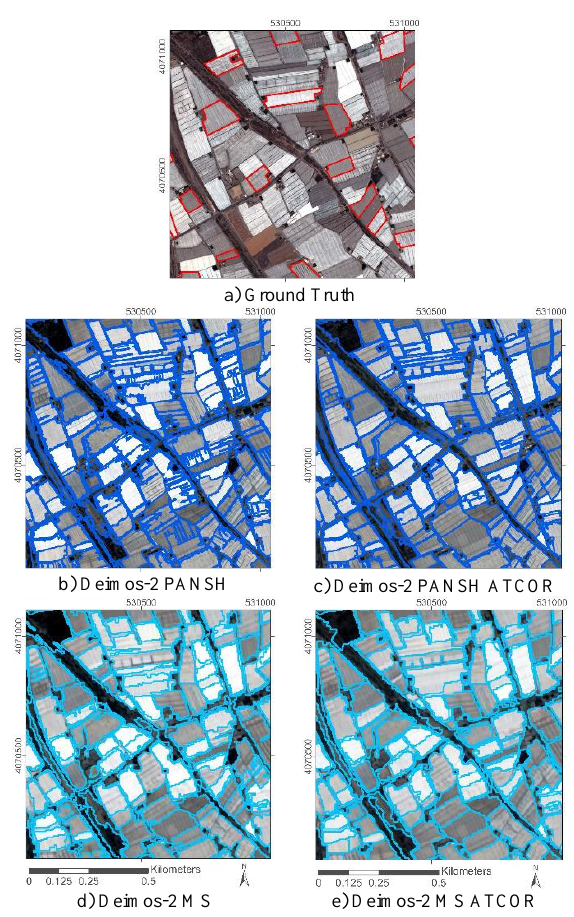
Figure 7 . Visual comparison of the best achieved segmentations using MRS and AssesSeg over the corresponding RGB orthoimages: a) Reference geometries (400 red polygons) over WV3 MS ATCOR orthoimage; b) Optimal segmentation (Navy blue objects) derived from Deimos-2 PANSH orthoimage; c) Optimal segmentation (Navy blue objects) derived from Deimos- 2 PANSH ATCOR orthoimage; d) Optimal segmentation (Clear blue objects) derived from Deimos-2 MS orthoimage; e) Optimal segmentation (Clear blue objects) derived from Deimos-2 MS ATCOR orthoimage. Coordinates in ETRS89 UTM Zone